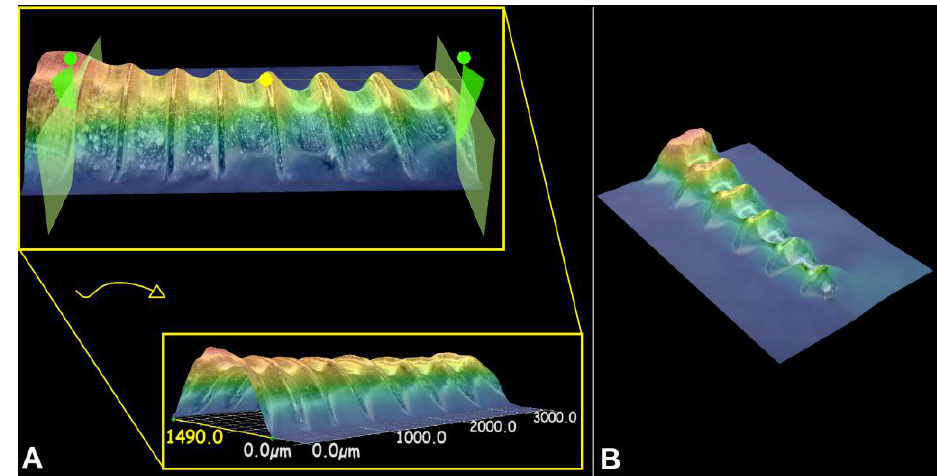
Figure 1. Temporary screws design. ( A ) Screws were tapered with a minor diameter of 1.5 mm and a length of 6 mm. ( B ) Threads had self-drilling ability.